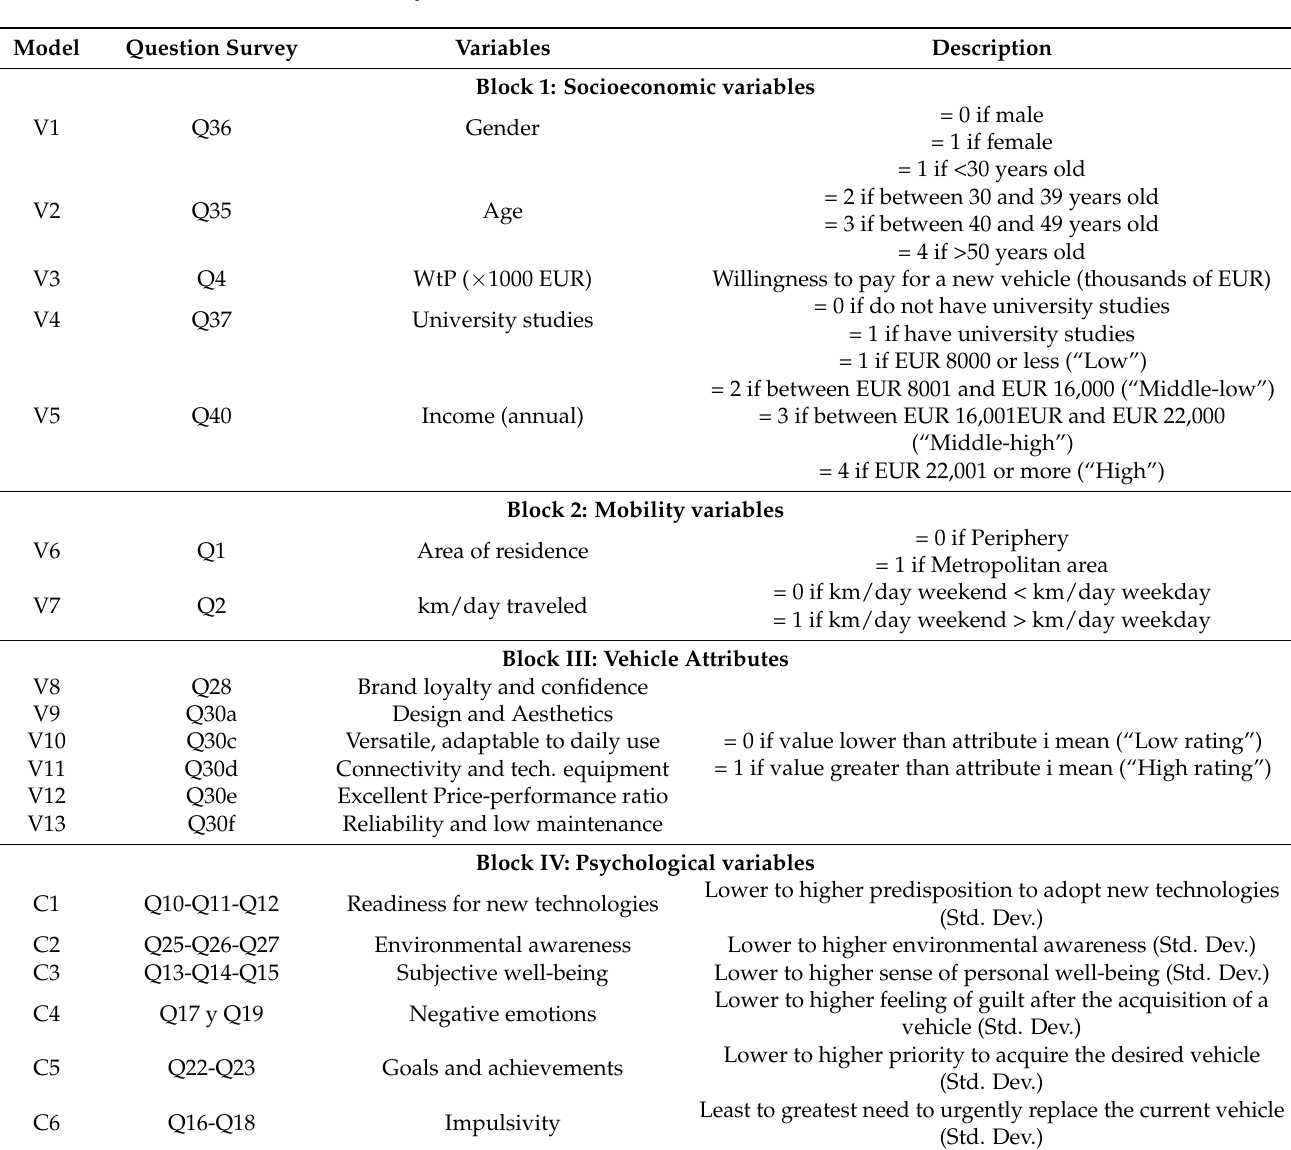
Table 3. Questionnaire